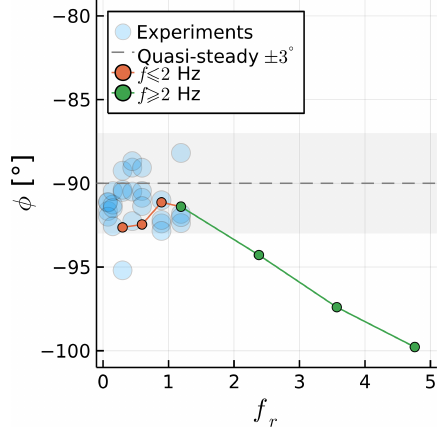
Figure 10. Maximum surge velocity effect on the phase between the rotor position and its thrust.